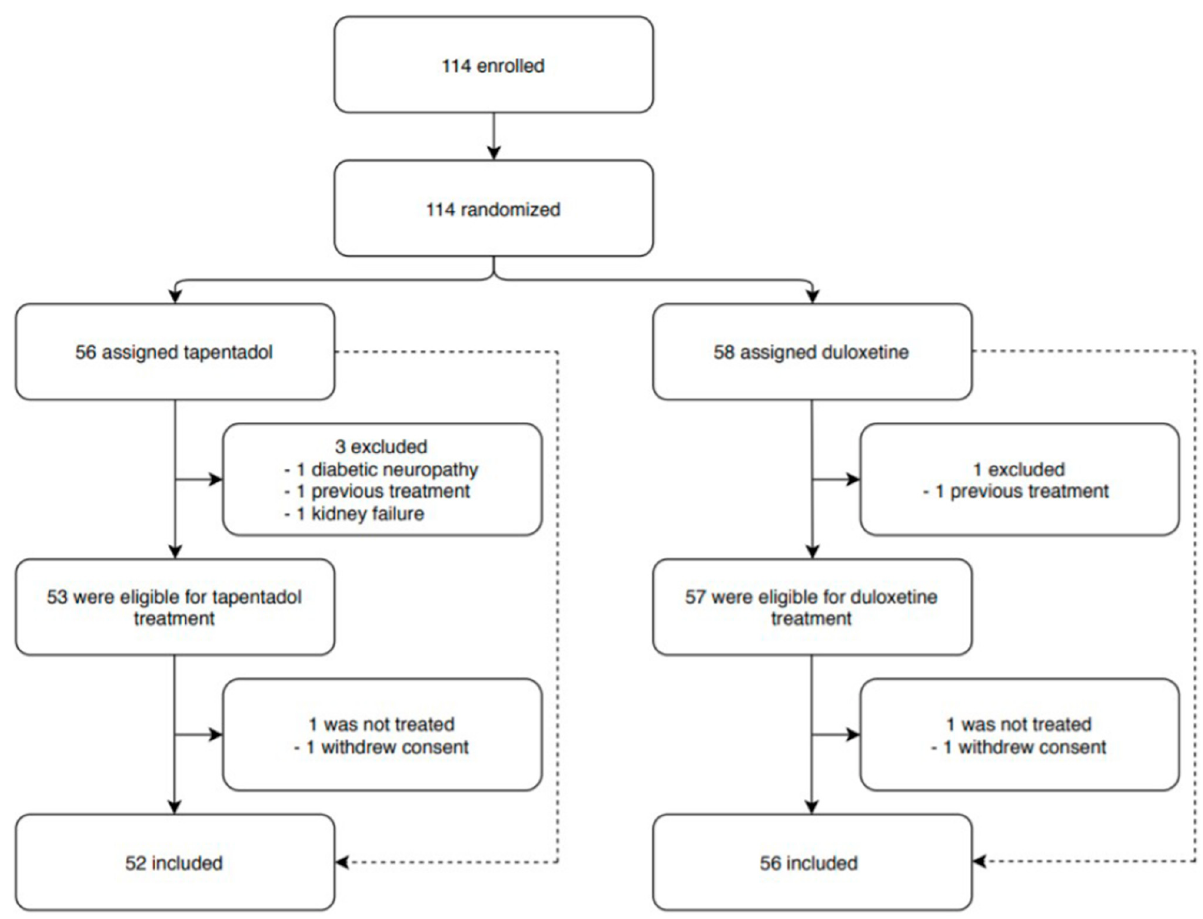
Figure 1. Trial profile.